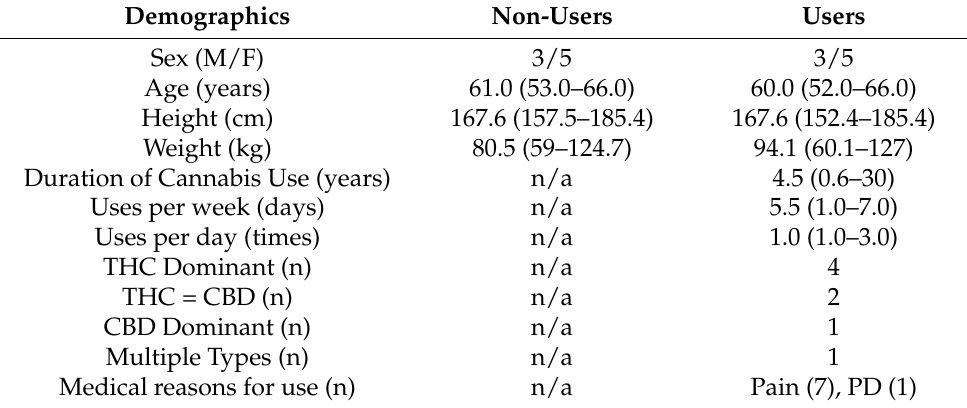
Table 1. Subject demographic information. Data are median